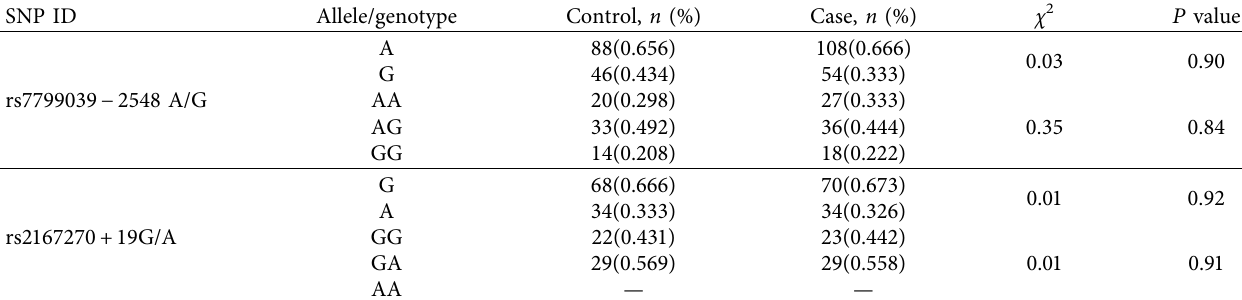
Table 2: Genotype and allele frequencies of rs7799039 ( LEP − 2548G/A) and rs2167270 (+19G/A) SNPs in case and control subjects. SNP